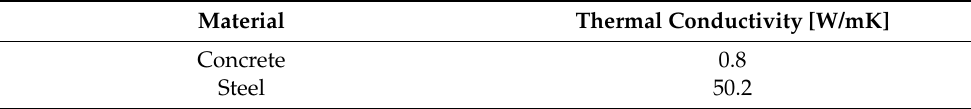
Table 1. Thermal conductivity of tunnel construction. Material Thermal Conductivity